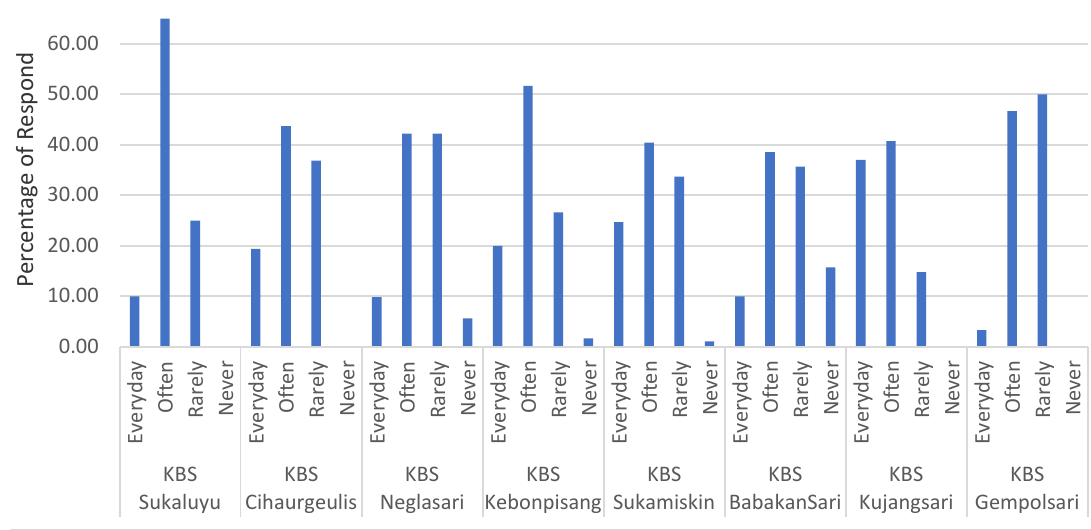
Fig. 8: Waste reduction habits of residents in KBS area